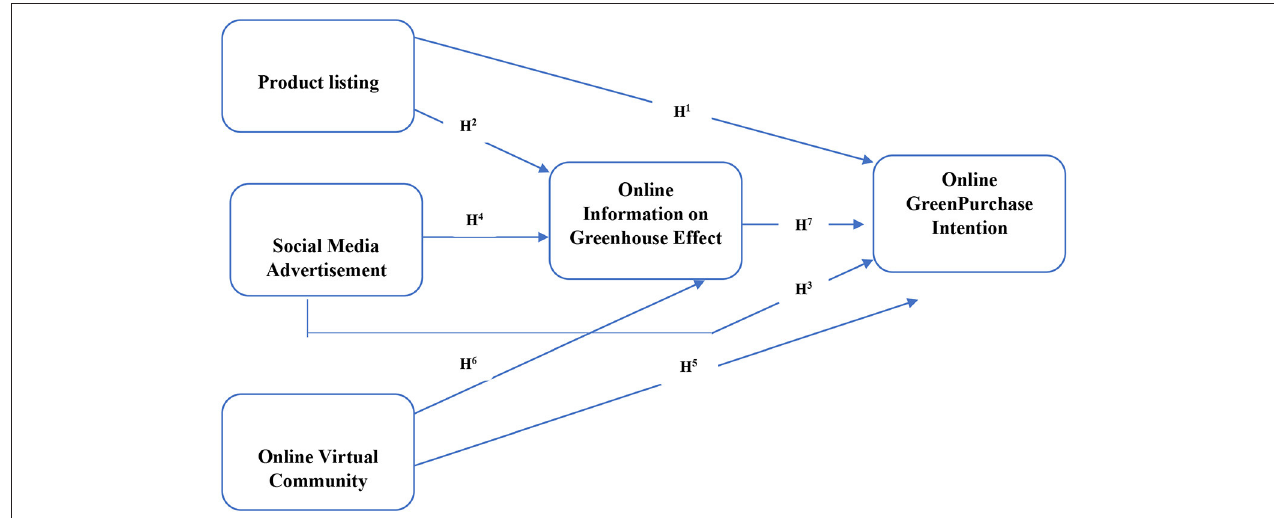
FIGURE 1 | The theoretical framework of potential variable influencing the greenhouse